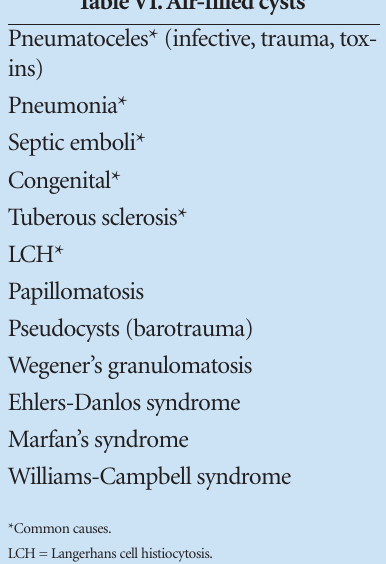
Table VI.Air-filled cysts 4 Pneumatoceles* (infective, trauma, tox- ins)